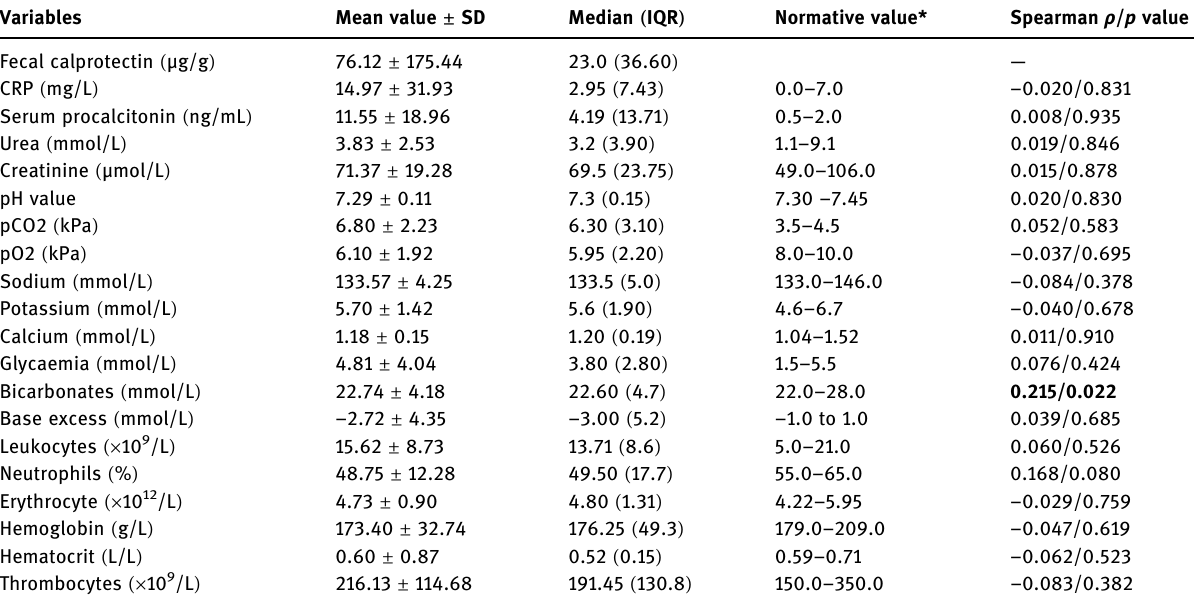
Table 2: Correlations of laboratory values and calprotectin